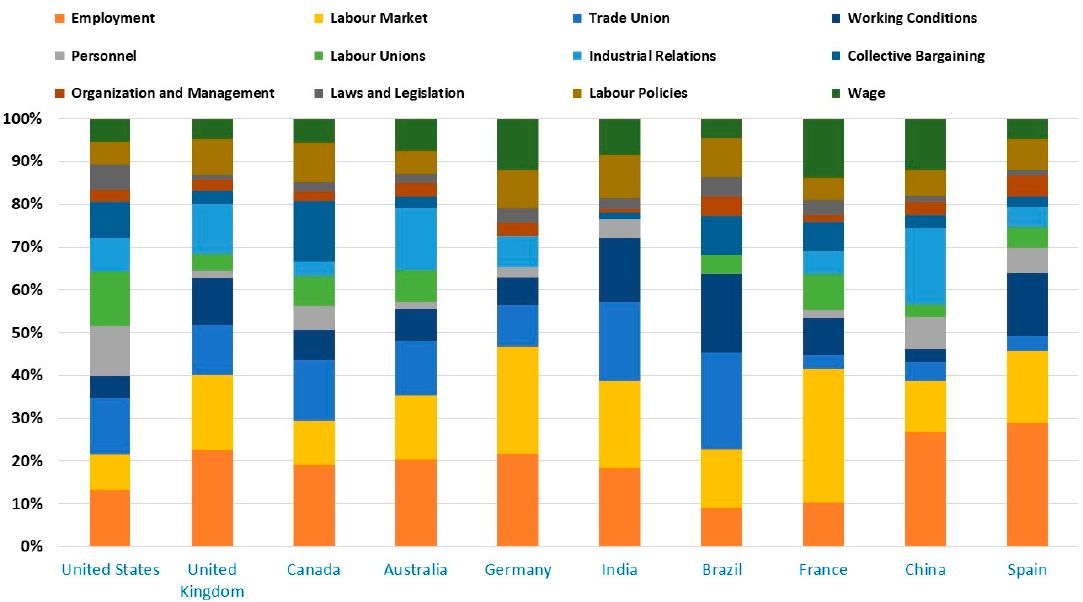
Figure 12. Distribution of main keywords by country as a percentage of their own publications.